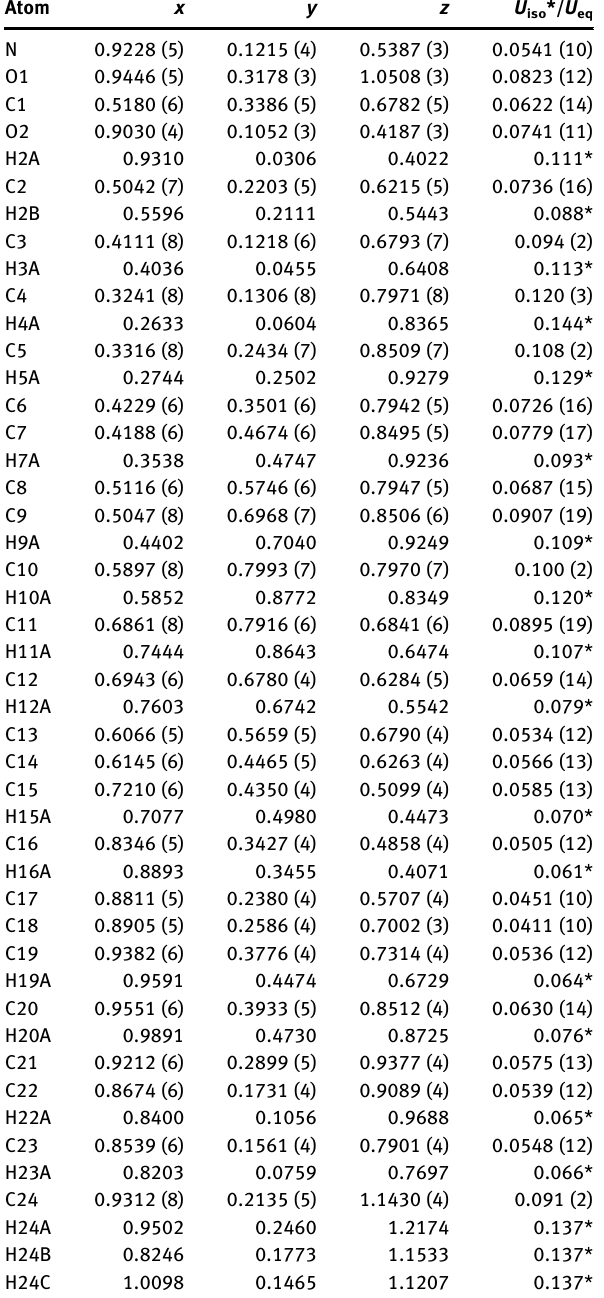
Table  : Fractional atomic coordinates and isotropic or equivalent isotropic displacement parameters (Å  ).